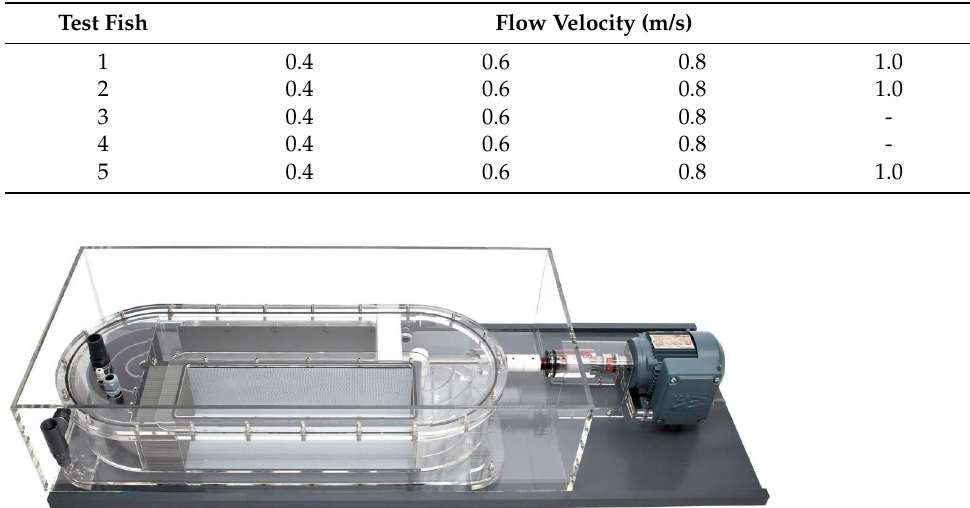
Figure 2. Loligo swim tunnel (https://www.loligosystems.com, (accessed on 10 May 2020).